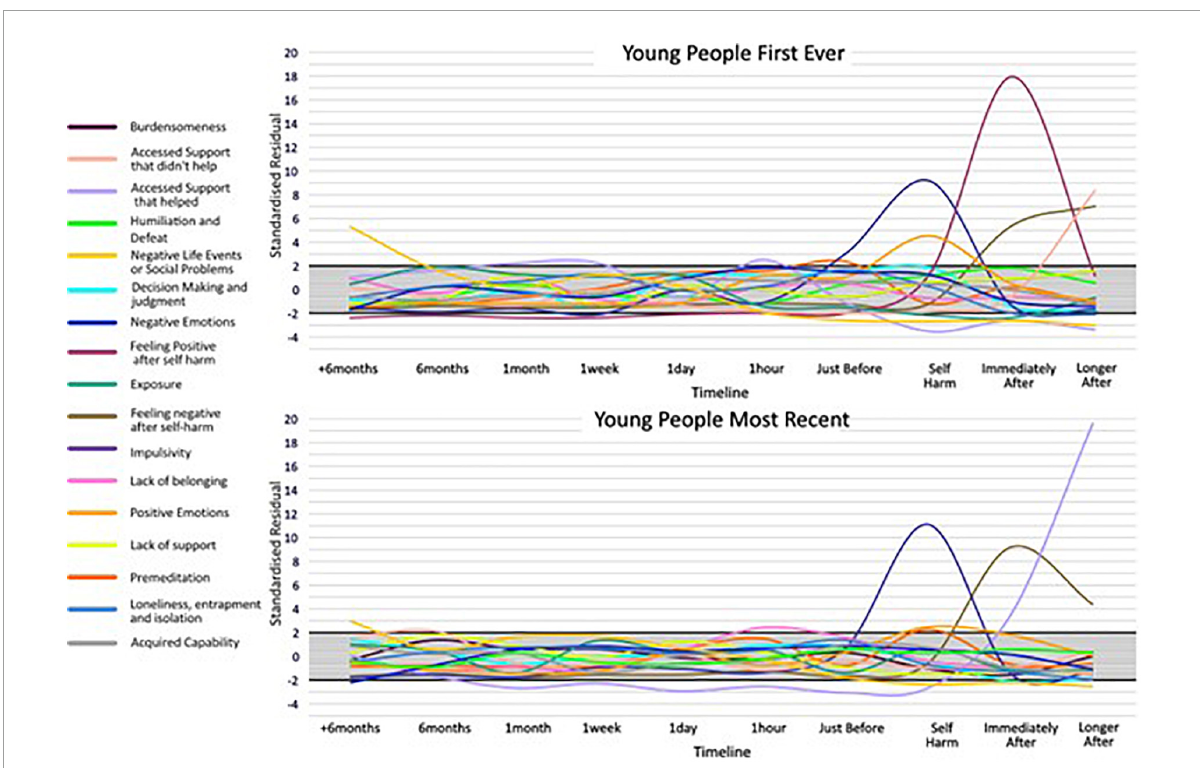
FIGURE3 Indicator Wave graphs showing the temporal organization of categories where at least one time point reached ± 2 for young people first ever and most recent episode of self-harm, SRs ± 2 indicating higher or lower frequency than would be expected by